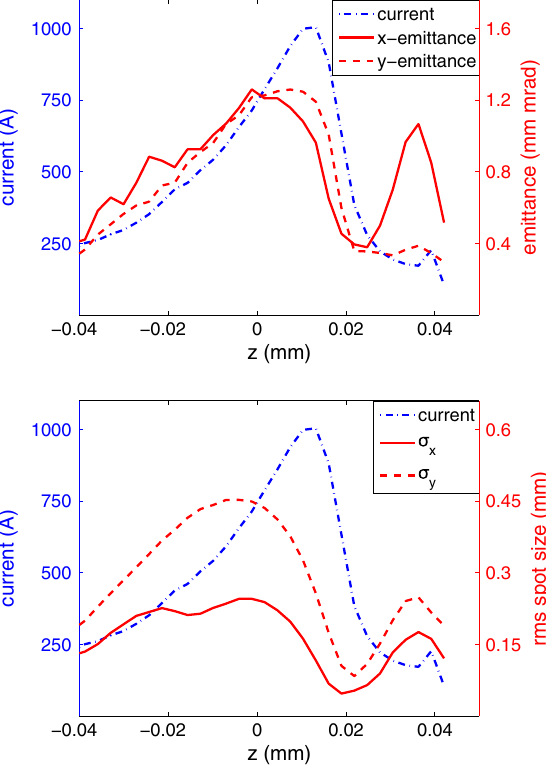
FIG. 13. Matching parameter BMAG as a function of the longitudinal position within the bunch (top) and simulated longitudinal SASE pulse distribution (bottom) for the start-to- end simulation corresponding to the machine settings of the 13.5 nm run. The head of the bunch is to the right-hand side of the figure (0.02 mm corresponds to 66 fs).